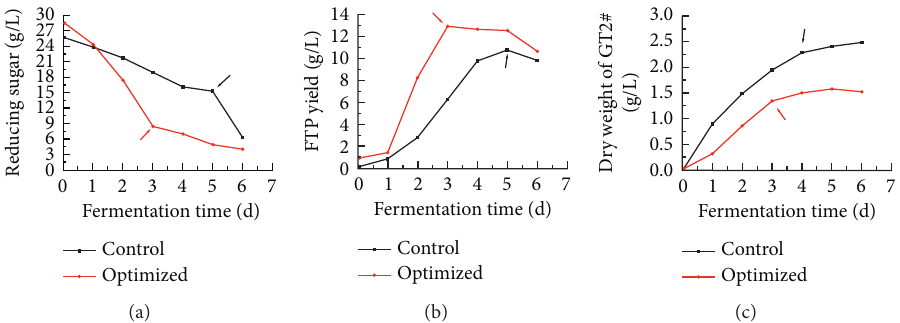
Figure 4: Comparison of fermentation in an optimized and preoptimized medium in a 5L fermentor. (a) RG (reducing sugar), (b) FTP yield, and (c) dry weight of GT2#.